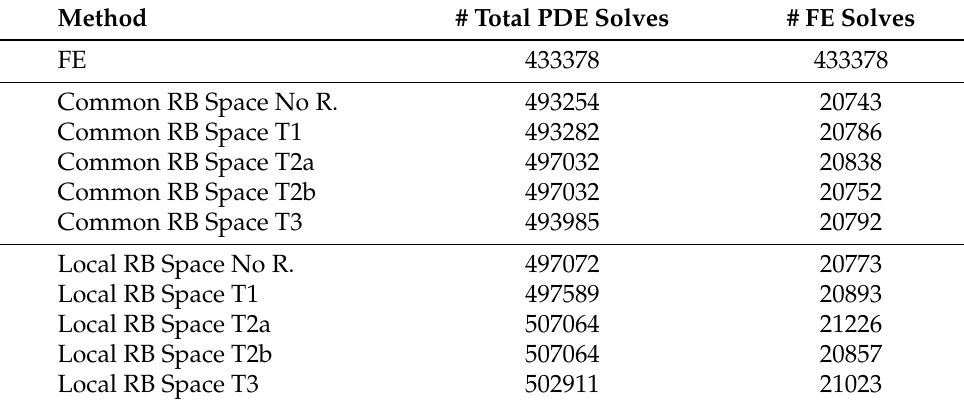
Table 1. Total PDE and only FE solves for the tested